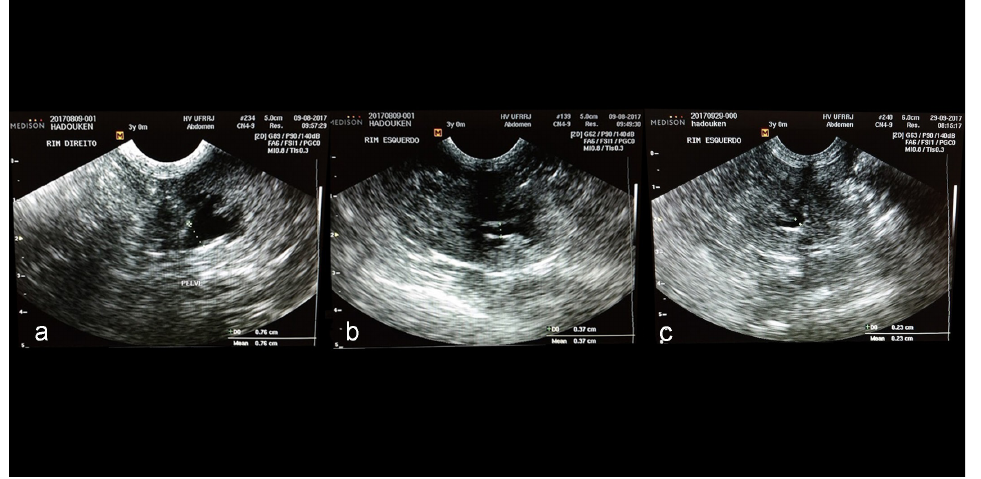
Figura 3. Imagem ultrassonografica da pelve renal antes e após o tratamento. (a) Pelve renal direita antes do tratamento medindo 0,76 cm; (b) Pelve renal esquerda antes do tratamento medindo 0,37 cm; (c) Pelve renal esquerda após o tratamento medindo 0,23